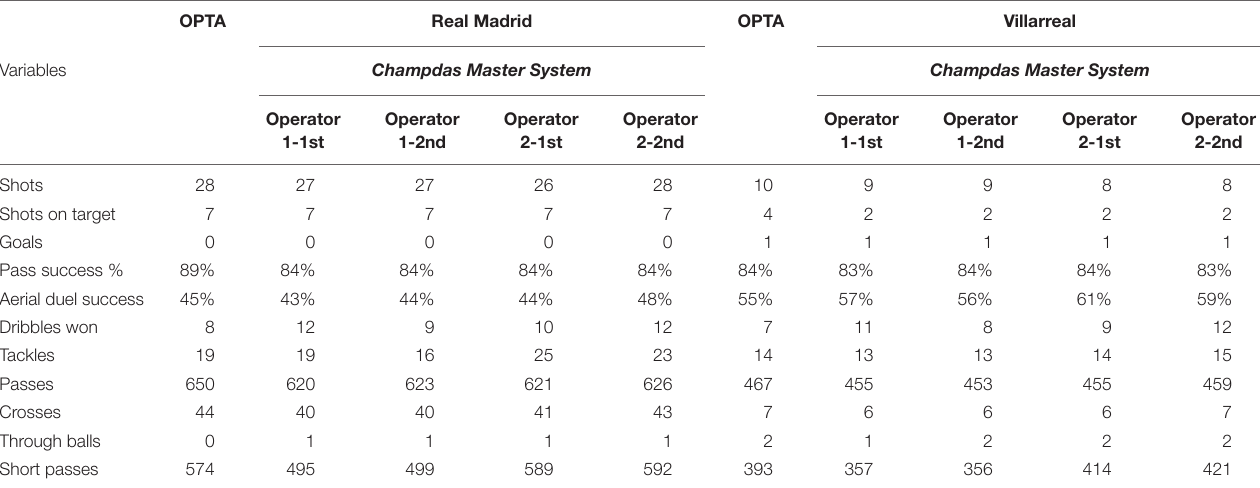
TABLE 6 | Match events provided by OPTA Sports and Champdas Master System